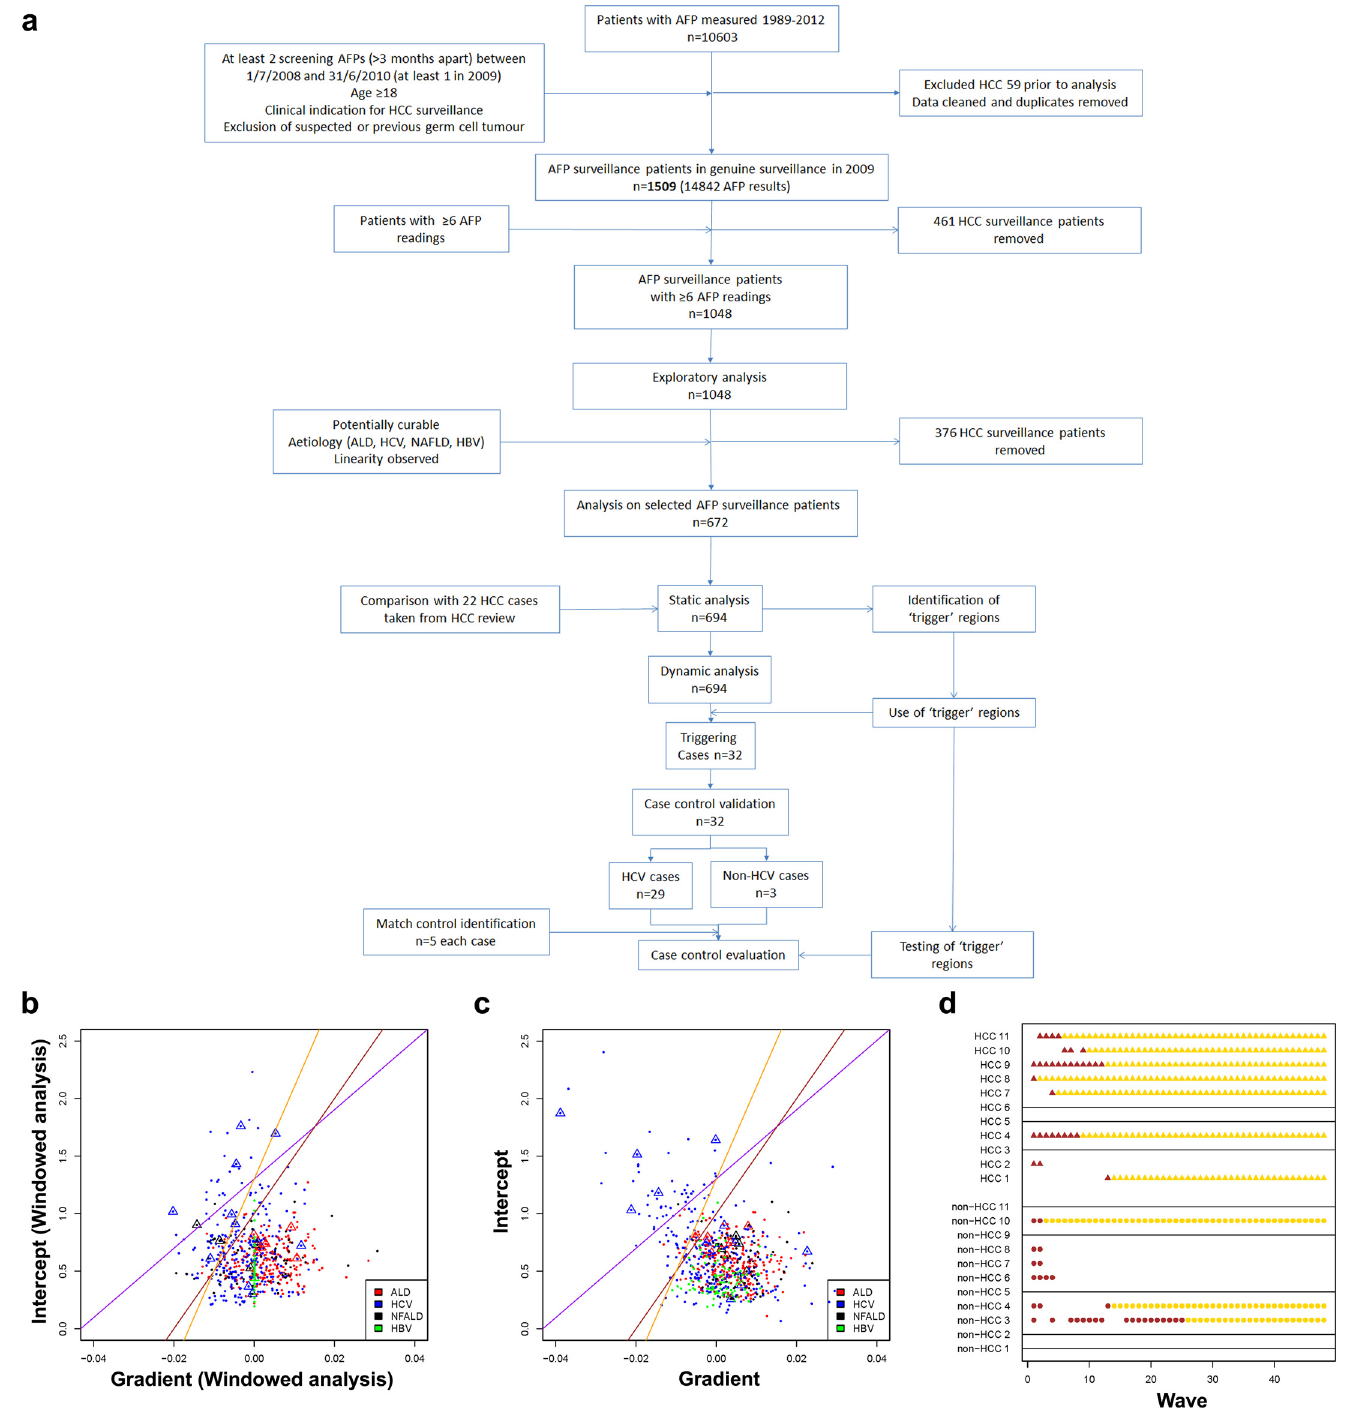
Fig 3. Using dynamic analysis of AFP provides a methodology for identifying patients at high risk of HCC. A ) Workflow for the development of an algorithm for HCC detection using AFP. The HCC surveillance cohort refined to patients with specific characteristics prior to formal Bayesian analysis in static and dynamic modes. In static mode a trigger zone was established, which was then tested dynamically. Estimated patient-specific intercept and gradient parameters plotted against each other. Estimates were taken from `windowed' version B ) `full-data' version C ) of full-trajectory retrospective Bayesian analysis. Triangles denote confirmed early-diagnosed HCC cases. Diagonal lines define regions of parameter space (above the line) that might indicate emerging HCC cases: purple — passes through (x, y) = (-0.01, 1) and (0, log20); brown — passes through (x, y) = (-0.01, 0.5) and (0, 1); yellow —